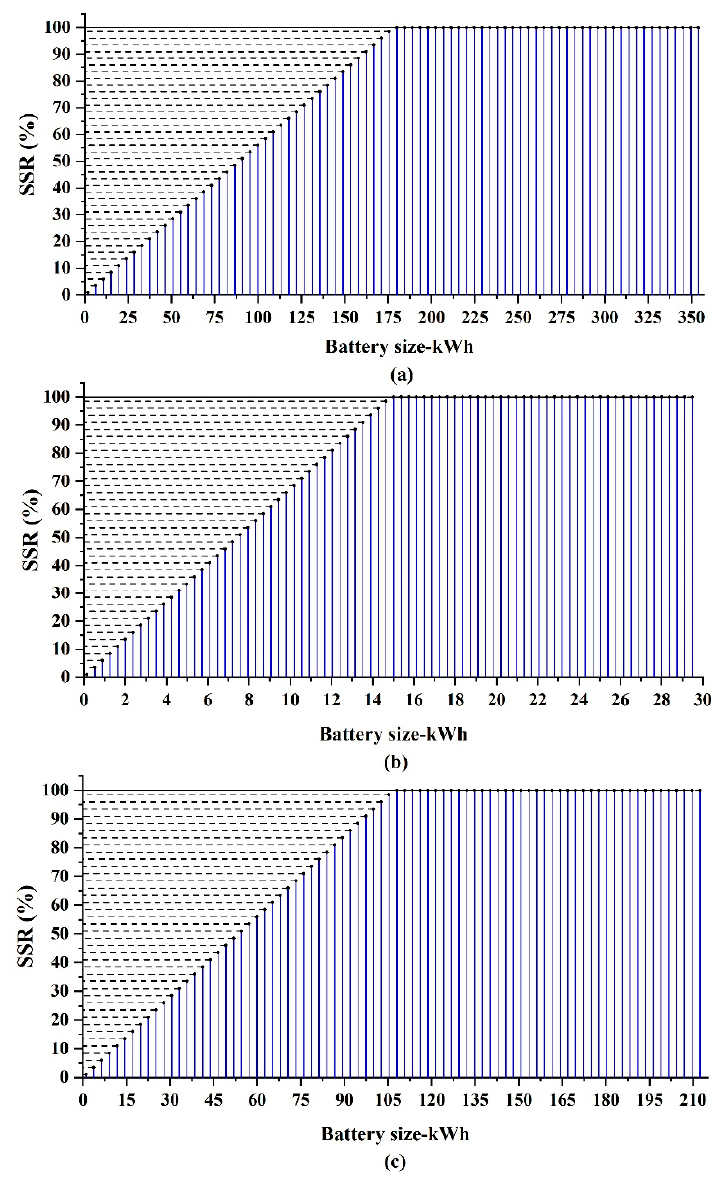
Figure 9. Impact of battery size on the SSR for ( a ) Evermore, ( b ) Gen Y, and ( c ) SHAC.